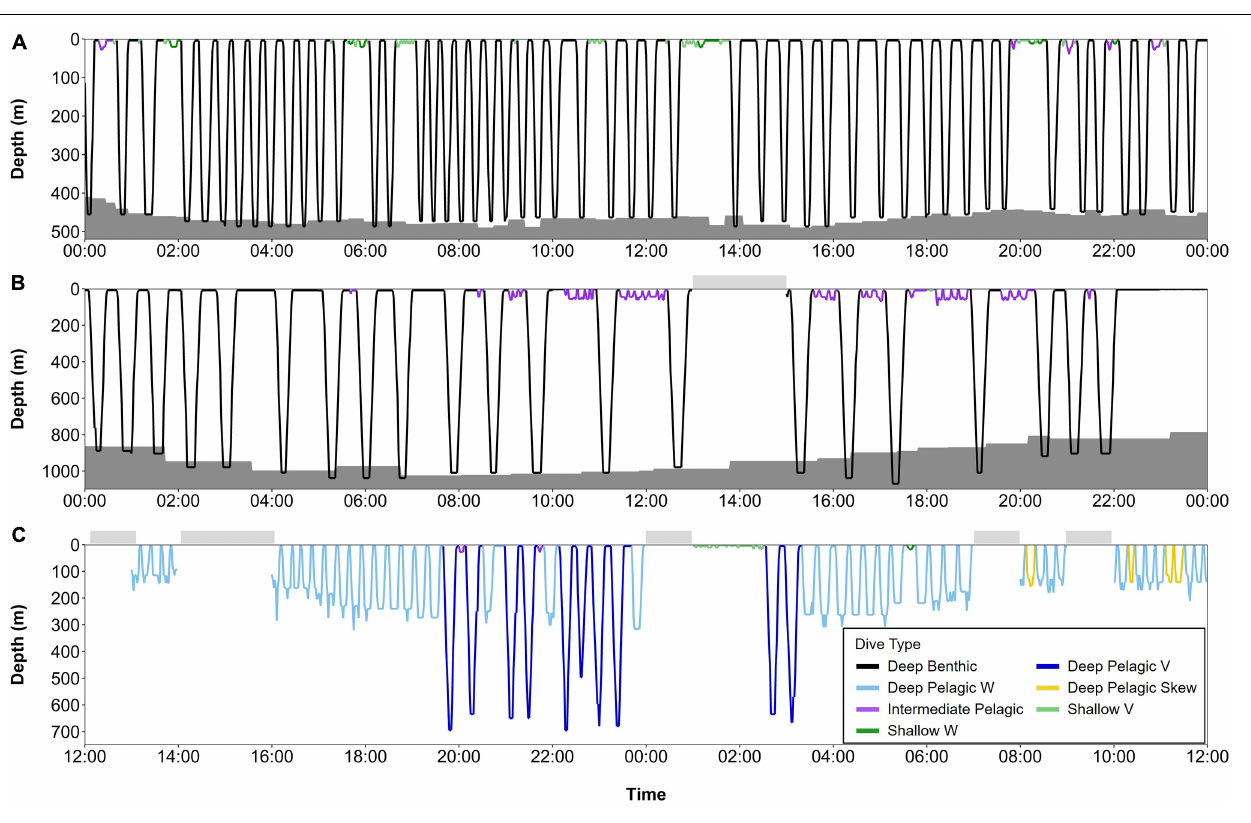
FIGURE 9 | Series of dives over 24-h periods from summer and early fall, color-coded by dive type: (A) beluga LC2018#1 on 23rd July 2018 (74.30 ◦ N, 110.68 ◦ W, Viscount Melville Sound), (B) beluga LC2018#6 on 18th June 2019 (70.55 ◦ N, 137.81 ◦ W, Beaufort slope), and (C) beluga LC2018#3 on 27th September 2018 (77.10 ◦ N, 178.12 ◦ W, Mendeleev Ridge). Gray shaded areas denote seafloor depth; dive depth sometimes exceeds the estimated seafloor depth due to error in the bathymetric maps, CTCRW-modeled locations, and dive depth. Horizontal bars above each plot denote periods with missing data. All times in UTC. Note the different y -axes scales. Locations of dive profiles shown in Figure 1